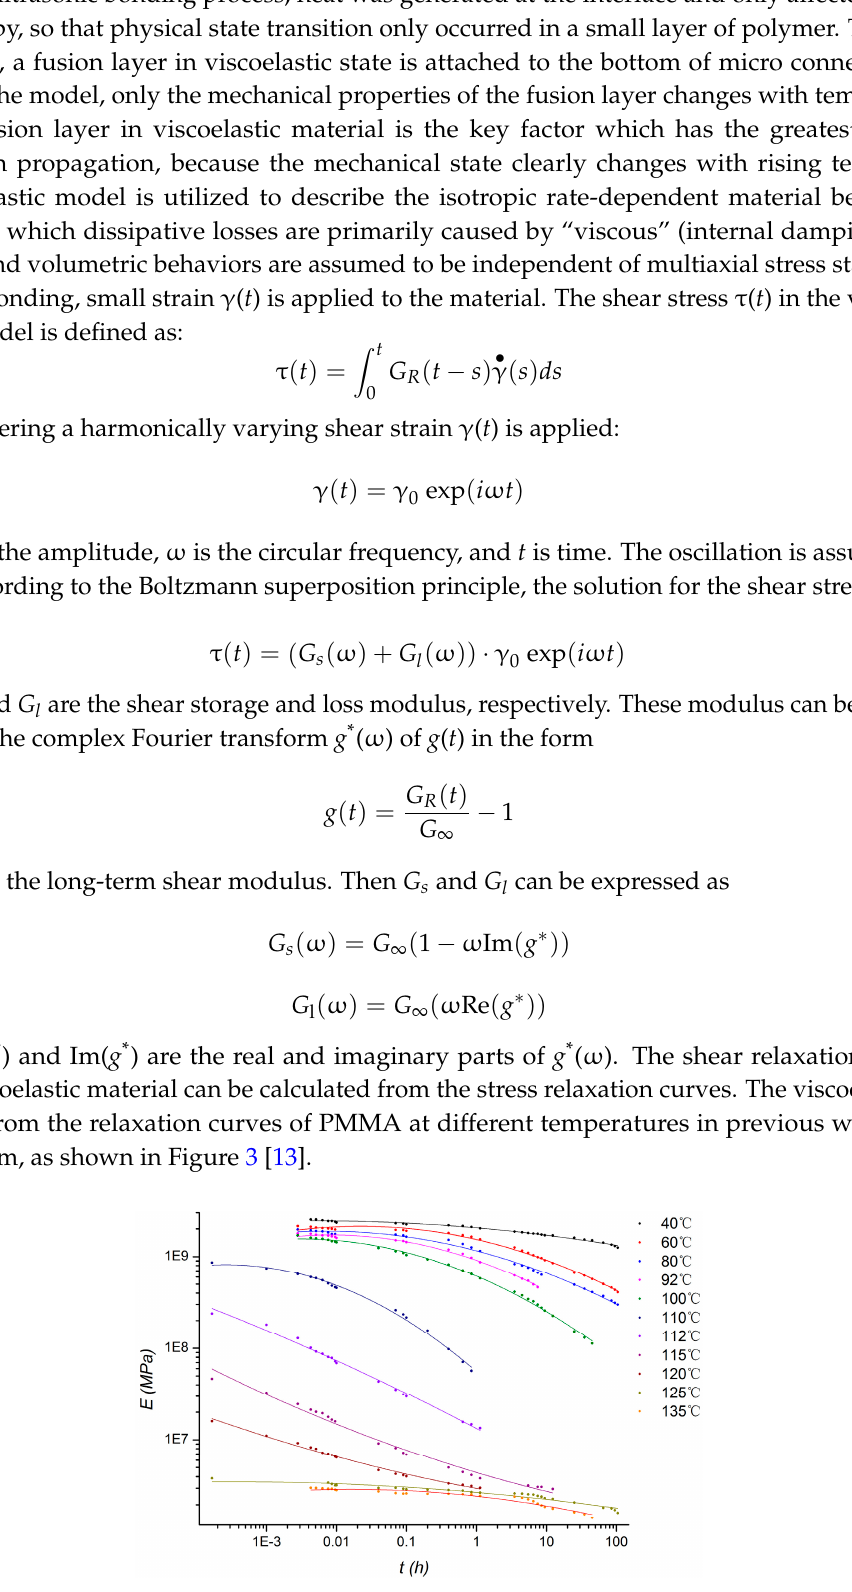
Figure 3. Stress relaxation curves of poly methyl methacrylate (PMMA) at different temperature.